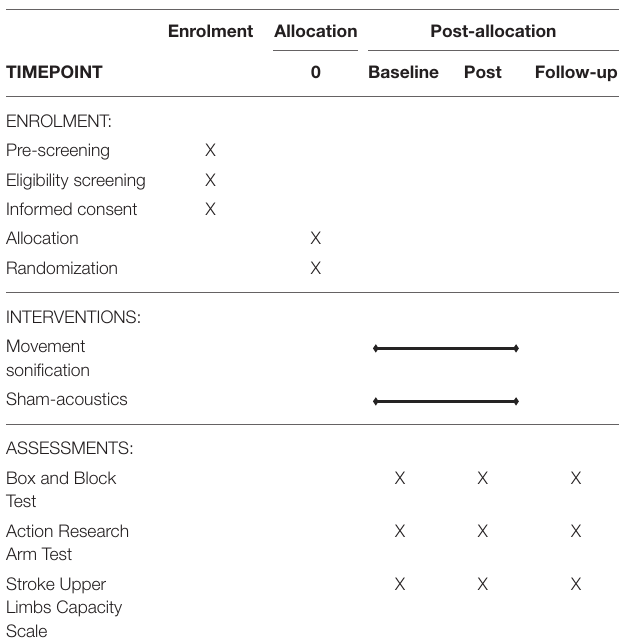
TABLE 1 | Time schedule of enrolment, interventions, and